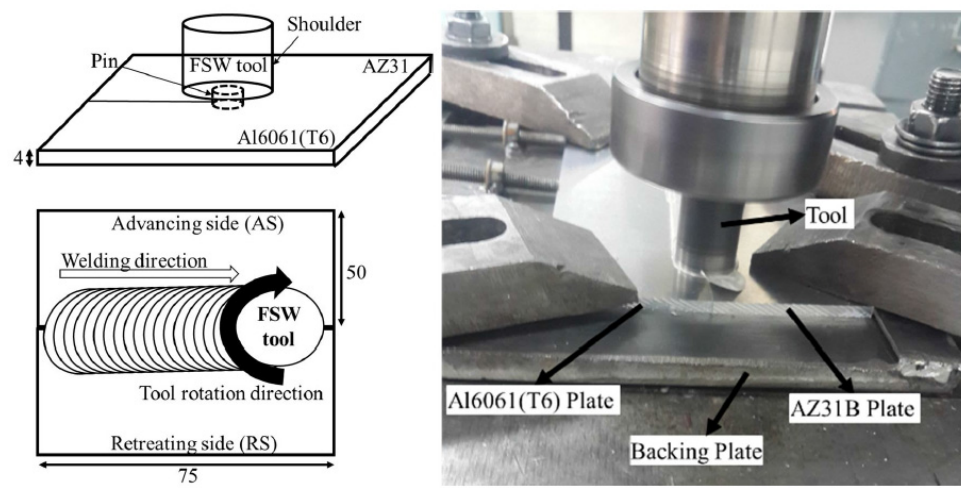
Figure 4. Joint design and dimensions (millimetre)